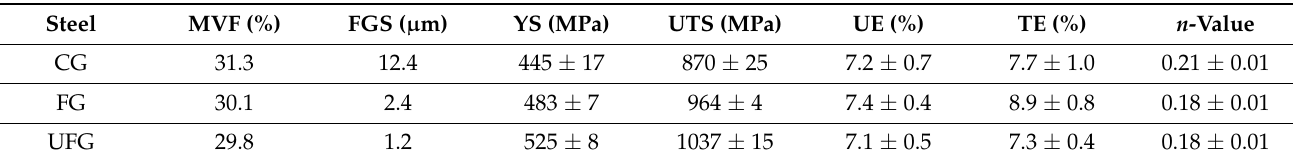
Table 1. Tensile properties of DP steels with different FGSs [48]. Reprinted with permission from ref. [48]. Copyright 2021 Elsevier.